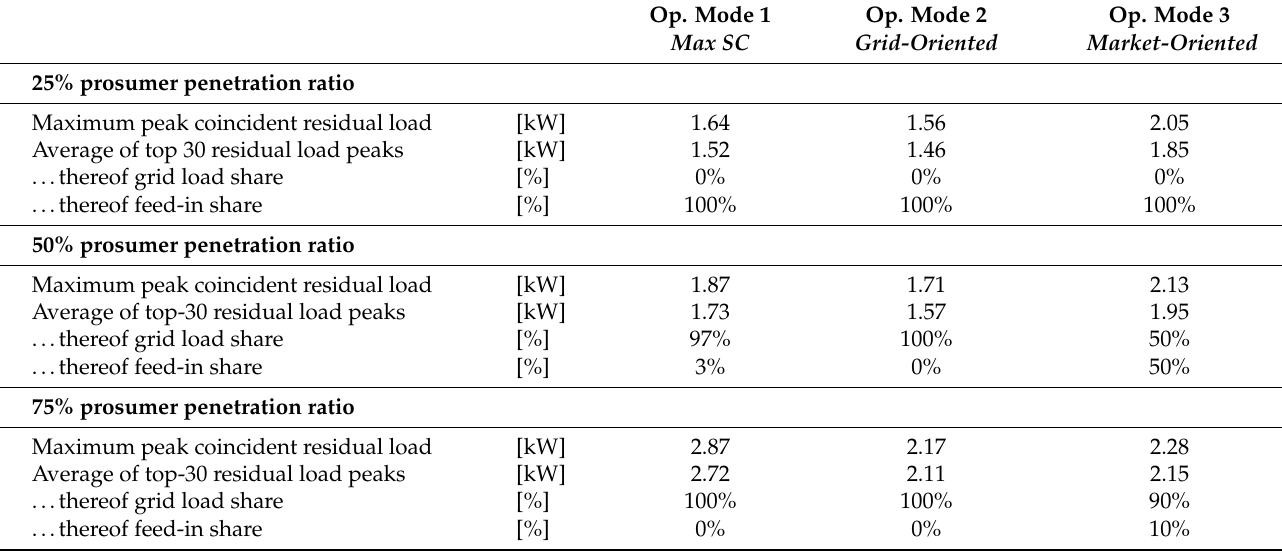
Table 5. Summary of grid-level